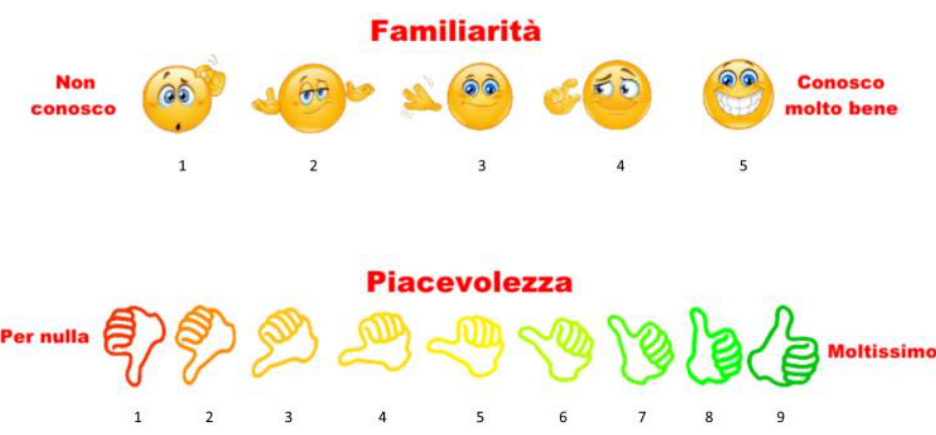
Figure 3. Self-Assessment Manikin (Familiarity and pleasantness). Screenshot of the user